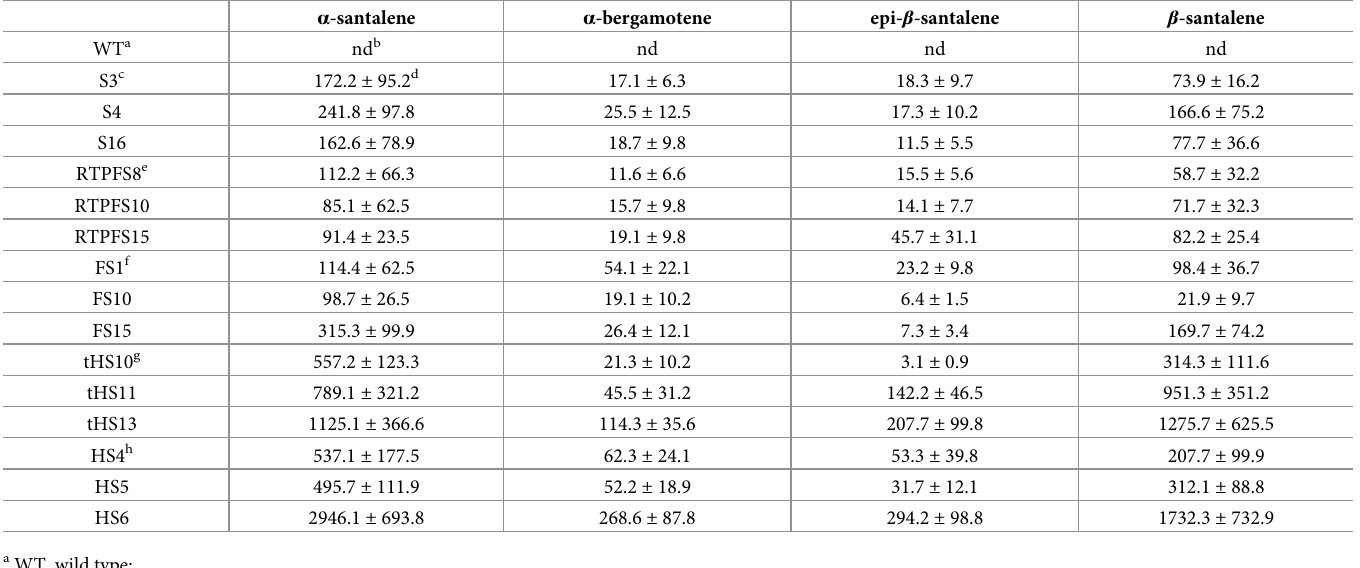
Table 2. Yields of santalenes and bergamotene in transgenic Nicotiana tabacum (ng � g -1 � fresh weight 24 h -1 ). α